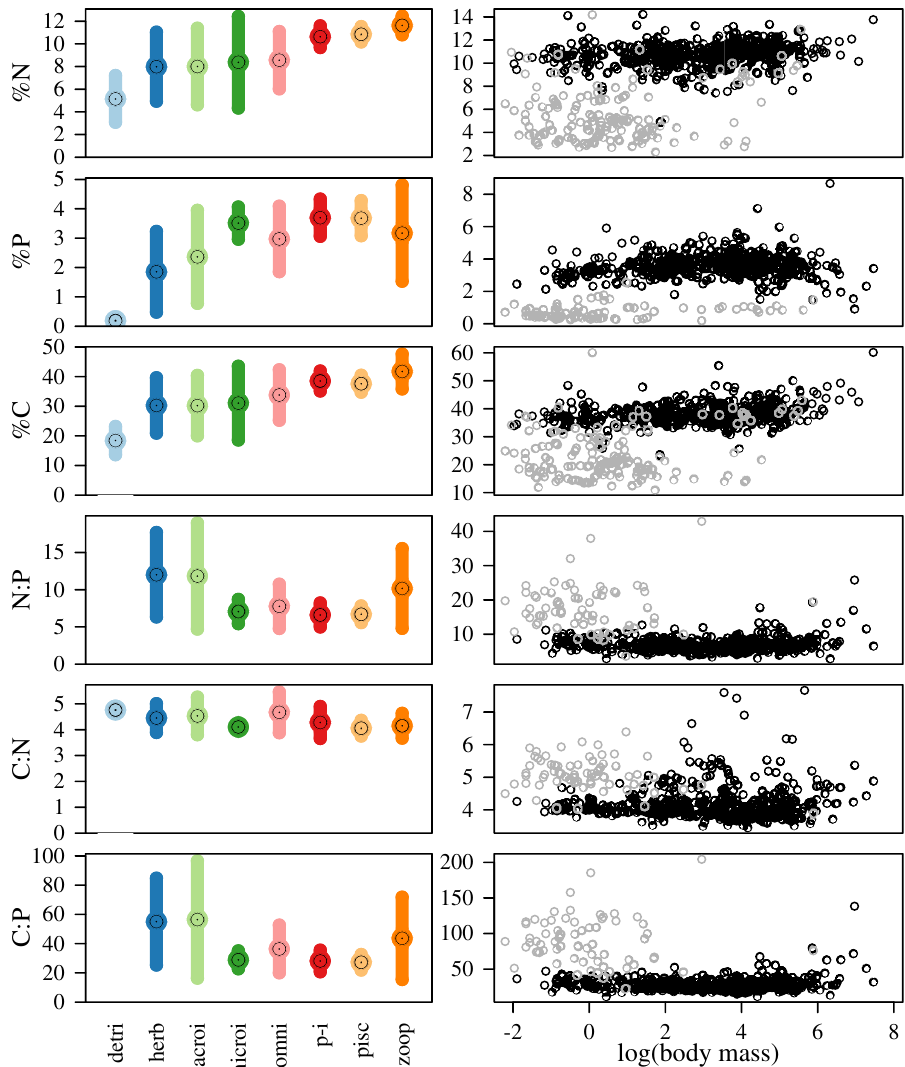
Figure 3. Left panels: Body nutrient content and stoichiometry across trophic groups. Bars indicate standard deviation around the mean (center point with black dot): “detri” = detritivore; “herb” = herbivore; “macroi” = macroinvertivore; “microi” = microinvertivore; “omni” = omnivore; “p-i” = piscivore and invertivore; “pisc” = piscivore; “zoop” = zooplanktivore. Right panels: data for log(body mass) and body nutrient content and stoichiometry. Note mass data was log10 transformed in analysis. Colors indicate datasets: gray = invertebrates only, black = vertebrates only.